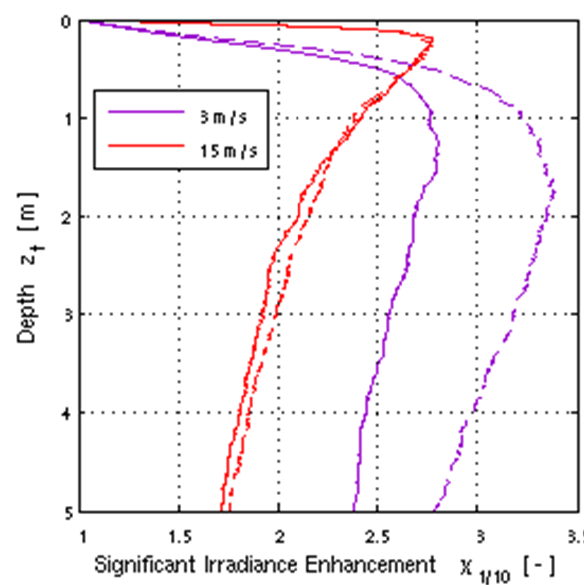
Fig. 7. Significant irradiance enhancement χ 1 / 10 for two wind ve- Fig. 7 : Significant irradiance enhancement χ locities with (dashed) and without (solid lines) long-wave modifica- and without (solid lines) long ‐ wave modification of the applied wave spectra (Fig. 1). 4 tion of the applied wave spectra (Fig.